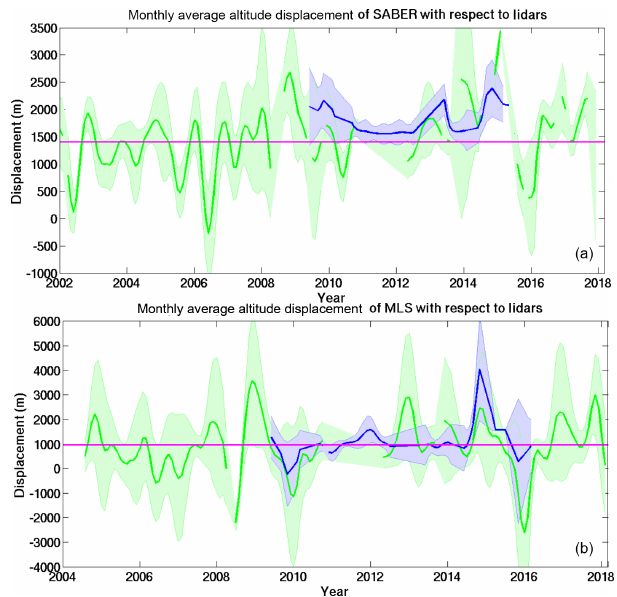
Figure 10. Panel (a) features the monthly average displacement of SABER measurements with respect to the OHP lidars (green for LTA and blue for LiO 3 S). The standard deviation is given as the shaded area. The mean offset (magenta) is 1446m with a standard error of 49m. Panel (b) shows the same analysis with the monthly average MLS displacement. The mean value is 911m with a stan- dard error of